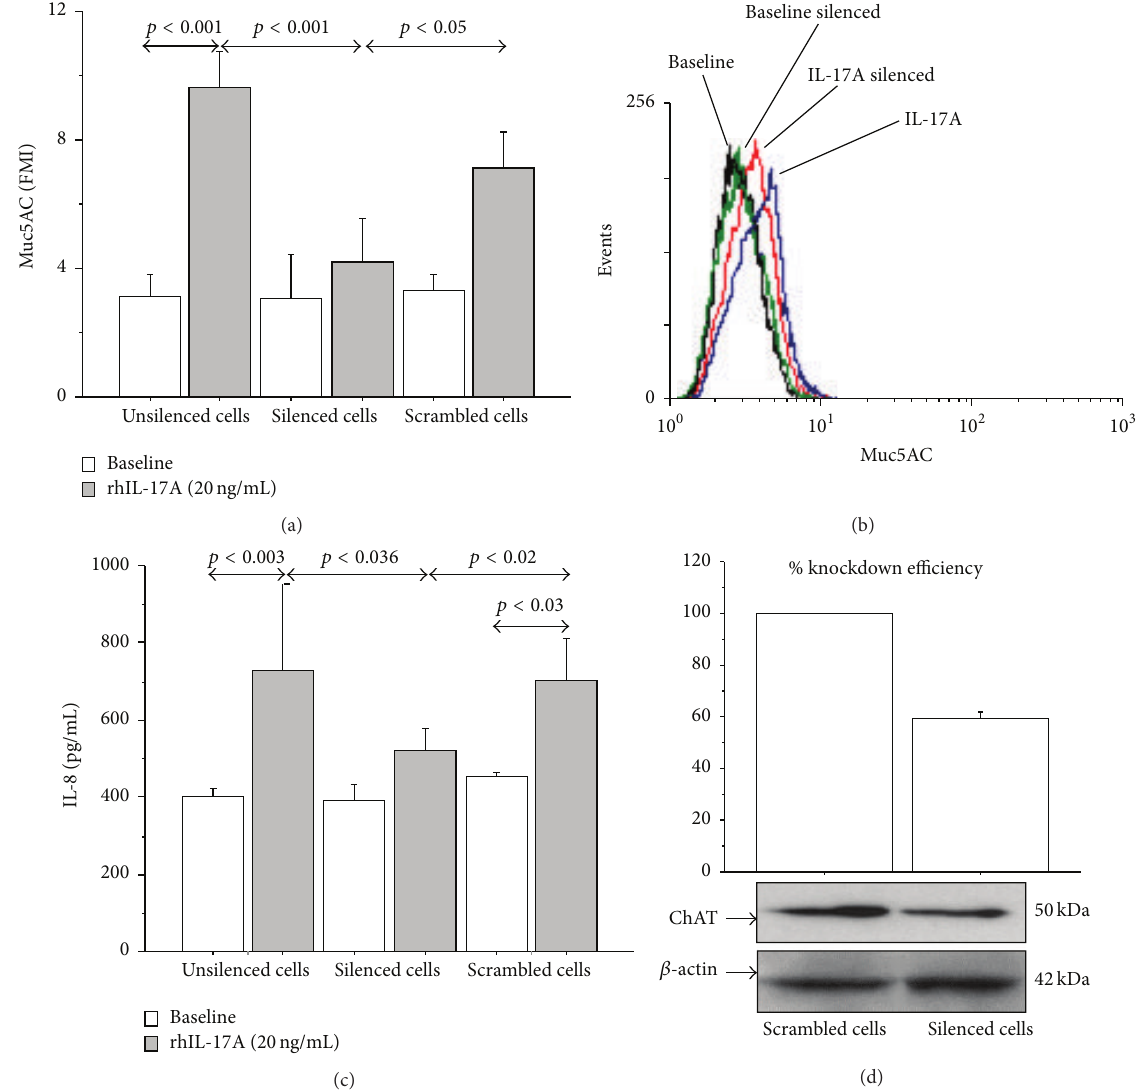
Figure 8: Silencing of ChAT mRNA reduced Muc5AC expression and IL-8 release in 16-HBE cells stimulated with rhIL-17A 20 ng/mL for 24 h. Cells were stimulated and analyzed to evaluate (a) Muc5AC expression in unsilenced cells and in cells transfected with siRNA for ChAT or scrambled siRNA by flow cytometry. Bars represent mean ± SD of fluorescence mean intensity (FMI) of three separate experiments. (b) Representative flow cytometry of Muc5AC is shown. (c) IL-8 release (pg/mL, by ELISA) in unsilenced cells and in cells transfected with siRNA for ChAT or scrambled siRNA. The values shown are the mean ± SD for three separated experiments. (d) Knockdown efficiency (%) of ChAT mRNA on ChAT protein expression. Bars represent mean ± SD of three separate experiments. Statistical analysis was performed by ANOVA test followed by Fisher’s PLSD multiple comparison